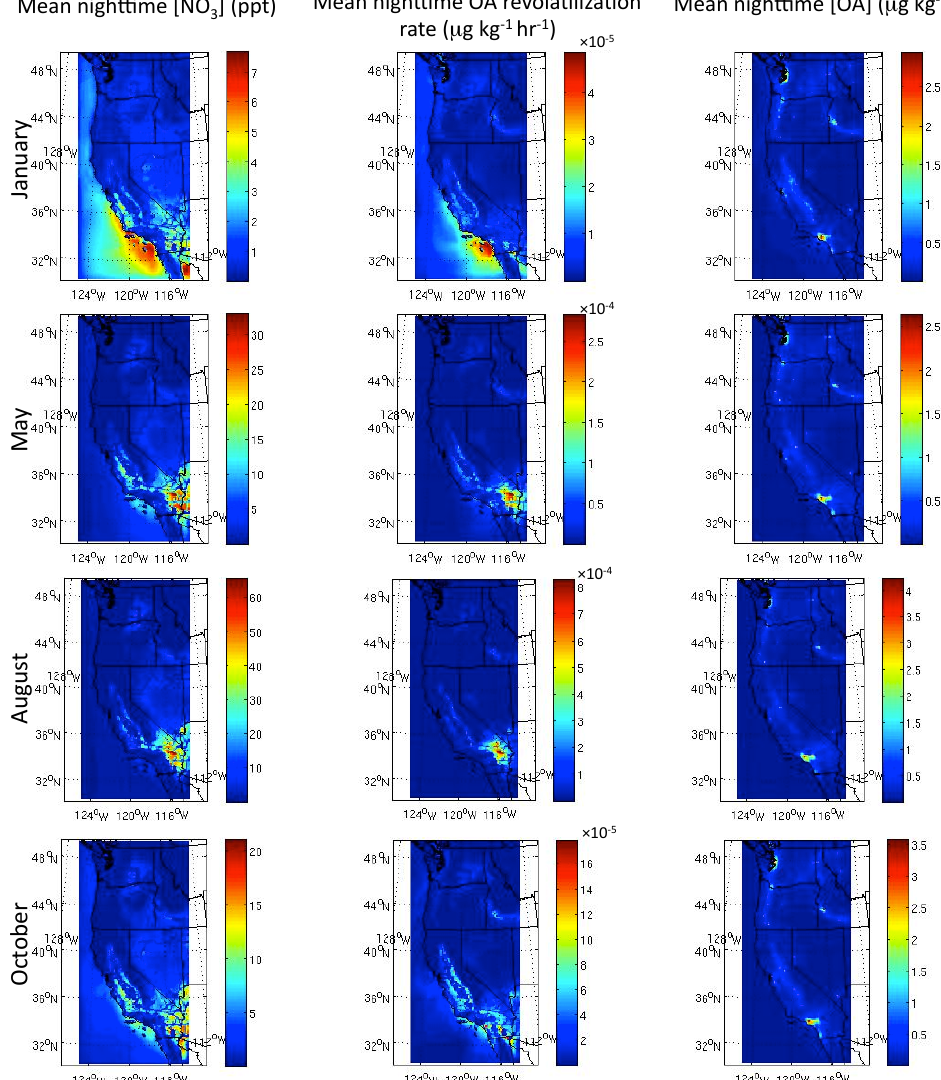
Fig. 5. Seasonal pattern of NO 3 -initiated OA revolatilization (sink) rate (center panels), which is calculated based on the hourly nighttime surface [NO 3 ] map (left panels) and nighttime [OA] (right panels). The monthly average of these hourly calculations is shown here.